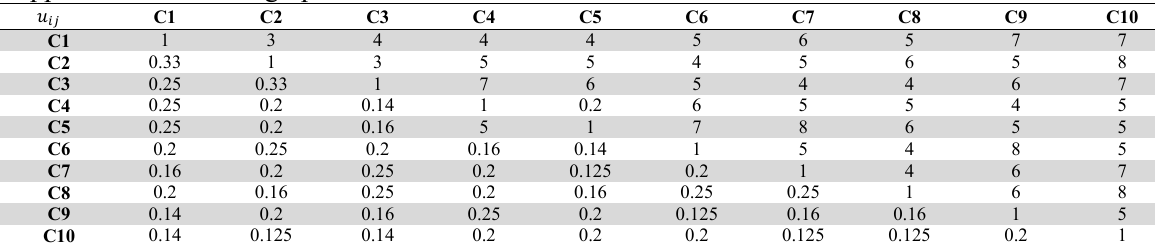
Upper bound of lexicographic decision matrix